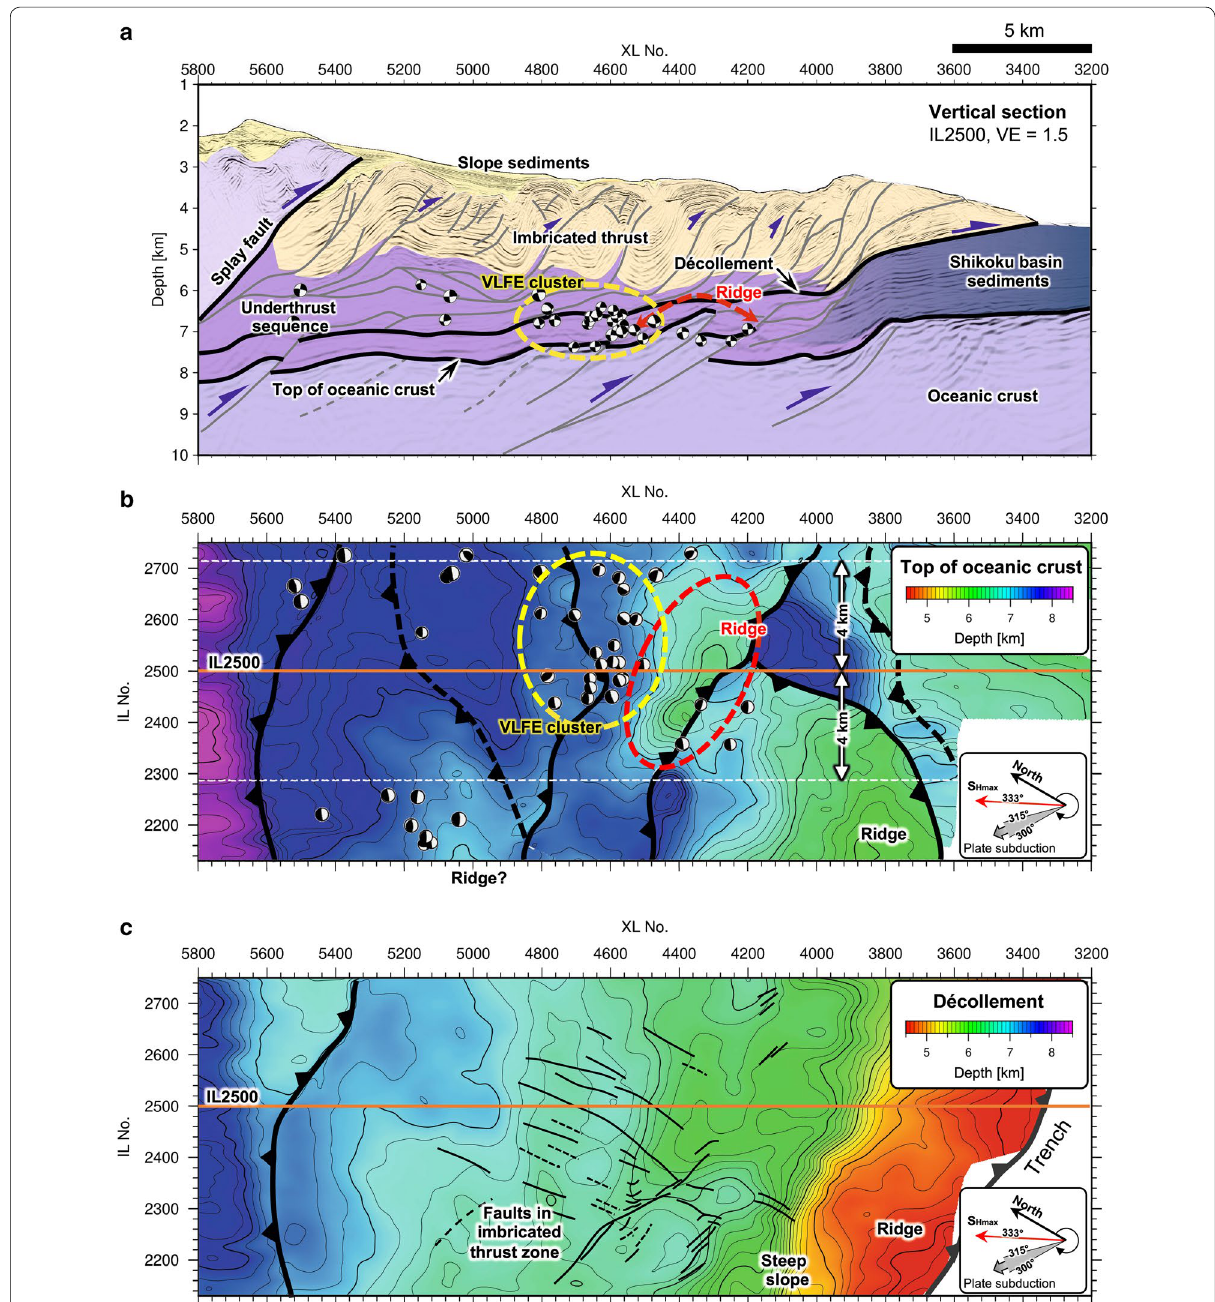
Fig. 7 Comparisons of the 3D seismic images, structural features, and VLFE source distributions. a CMT solutions within 4 km, approximately the maximum spatial error, from line IL2500 are projected on the seismic section. The vertical exaggeration (VE) of the seismic section is 1.5. Most of the selected VLFEs are located in low-reflectivity underthrust sediments on the landward side of the central ridge in the oceanic crust and are thought to consist of underconsolidated hemipelagic muds. b The oceanic crust topography and VLFE distribution with the CMT solutions. A cluster of VLFEs is located on the landward side of the central ridge in the oceanic crust. c The décollement topography and fault distribution in the shallow imbricated thrust sequence. The conjugate faults are also located on the landward side of the topographic high of the décollement. These comparisons imply that the maximum stress direction, which is inferred from the conjugate faults in the imbricated thrust zone, is consistent with the slip direction of VLFEs and the spatial relation between the VLFE distribution and the oceanic crust ridge. The consistencies suggest that the activity and distribution of VLFEs are controlled by the relief of the oceanic crust affecting the present stress field in the overlying